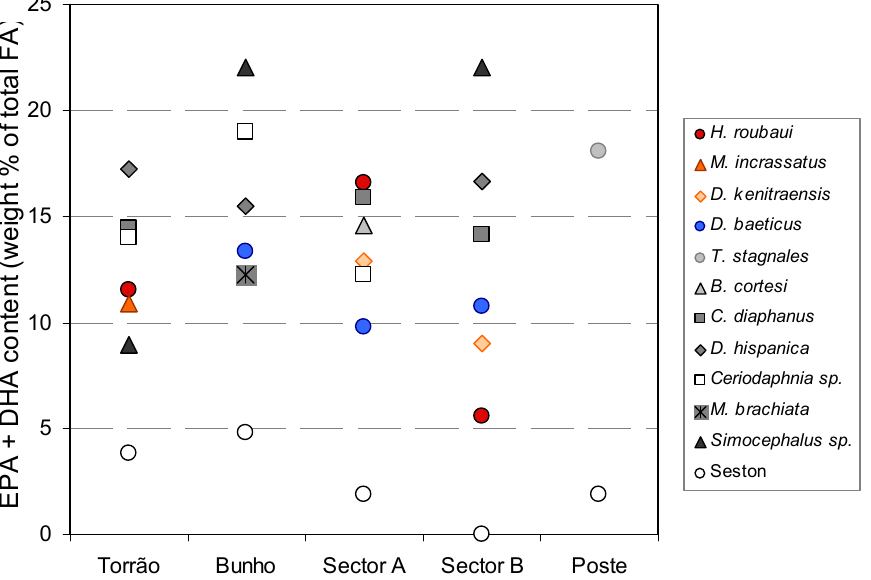
Figure 7. Variation of EPA and DHA content in zooplankton reserve lipids relative to seston content (<125 μ m particle size) in the corresponding pond of origin (open